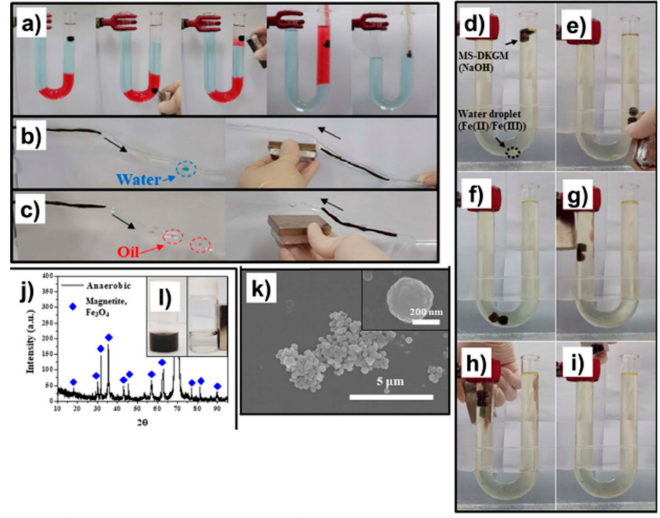
Figure 15. ( a ) Images showing the removal of heavy oils below the water layer in a U-shaped tube containing a multiphase solution composed of n-hexane (transparent), water (colored blue), and chloroform (colored red); ( b ) water or ( c ) chloroform droplets in hexane or water within a fine channel (diameter: 3 mm) using magnetic thread (MT)-DKGM (deacetylate konjac glucomannan) or MT-PDMS, respectively; ( d – i ) images showing the anaerobic reaction systems for the synthesis of magnetite NPs using MS-DKGM; ( j ) XRD and ( k ) SEM data of the black solution sample collected from the MS-DKGM balls after the reaction; ( l ) black solution samples ( left ) before and ( right ) after applying a magnetic field. Reproduced with permission from [164]. Copyright 2019 American Chemical